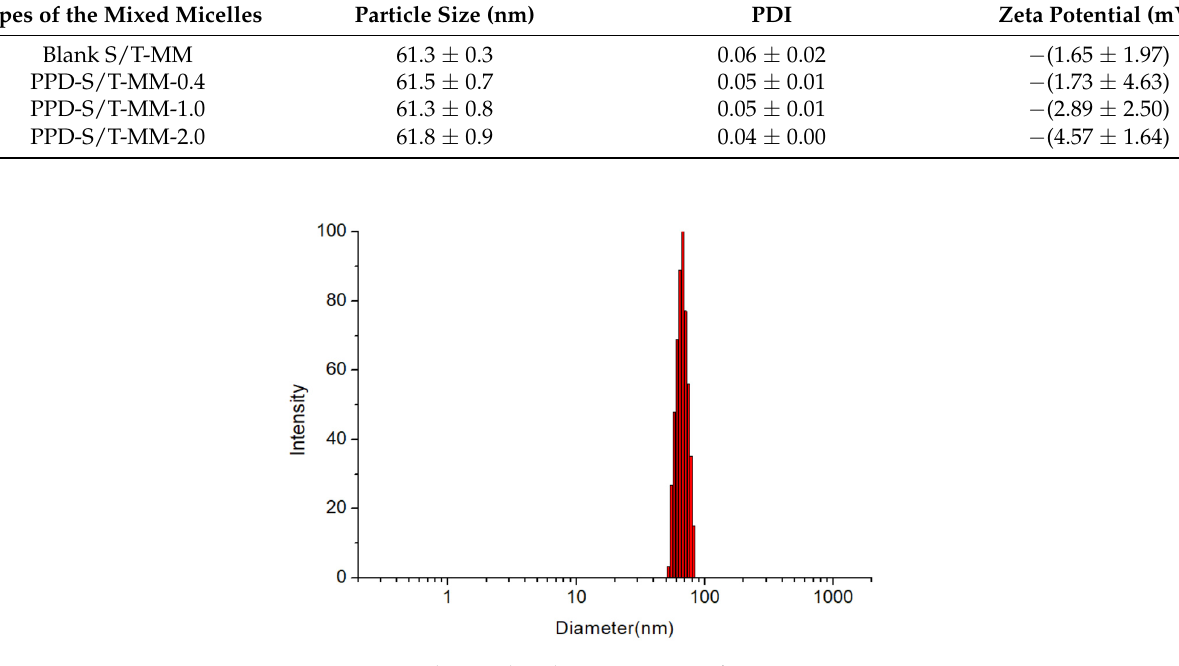
Figure 4. Particle size distribution in PPD-S/T-MM-1.0.